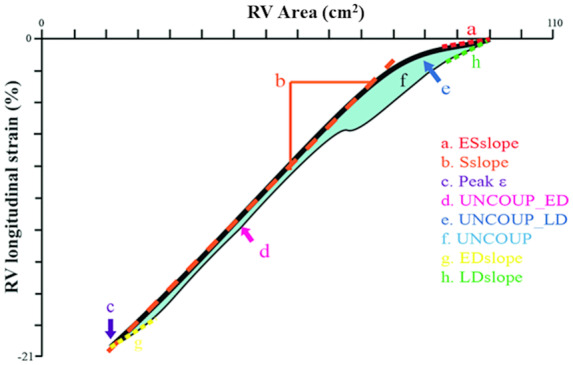
Schematic overview of the RV ϵ-area loop and the derived characteristics. The black line represents the ε-area loop, the thick part represents the systolic phase and the thin line the diastolic phase.